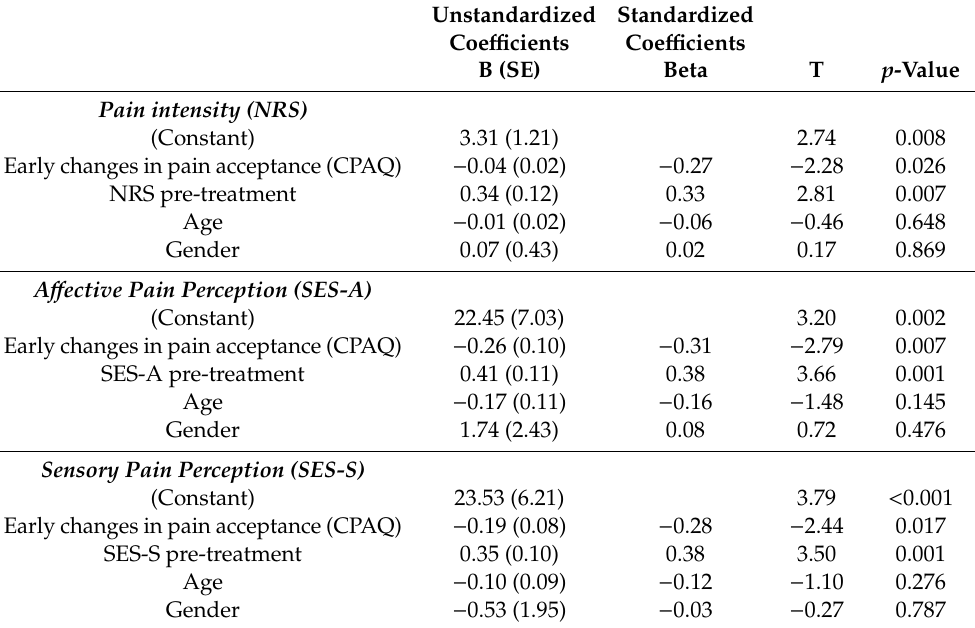
Table 4. Results of the multiple regression analyses testing early changes in pain acceptance as predictors of pain outcomes. N =